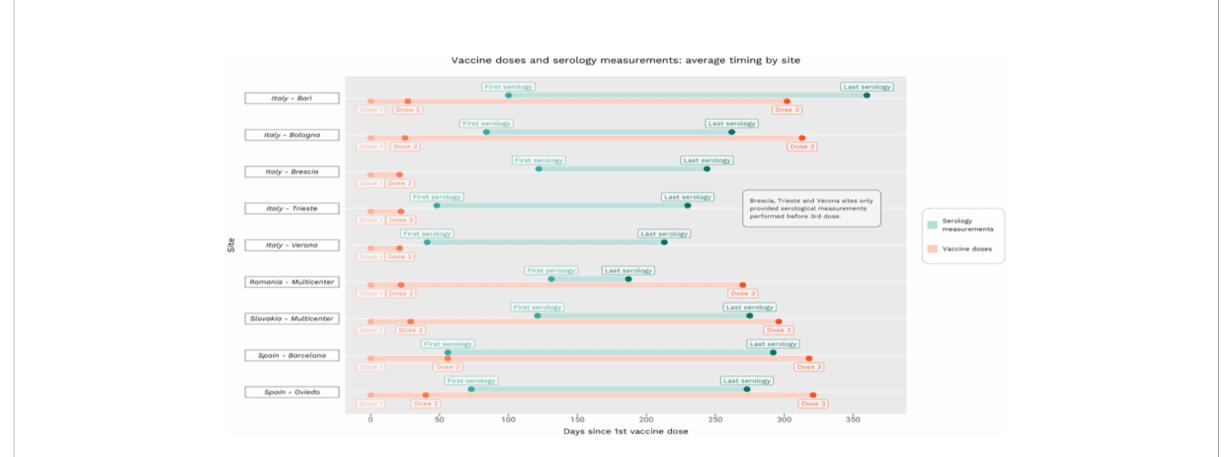
FIGURE 1 Timing of vaccination and serologic measurements by